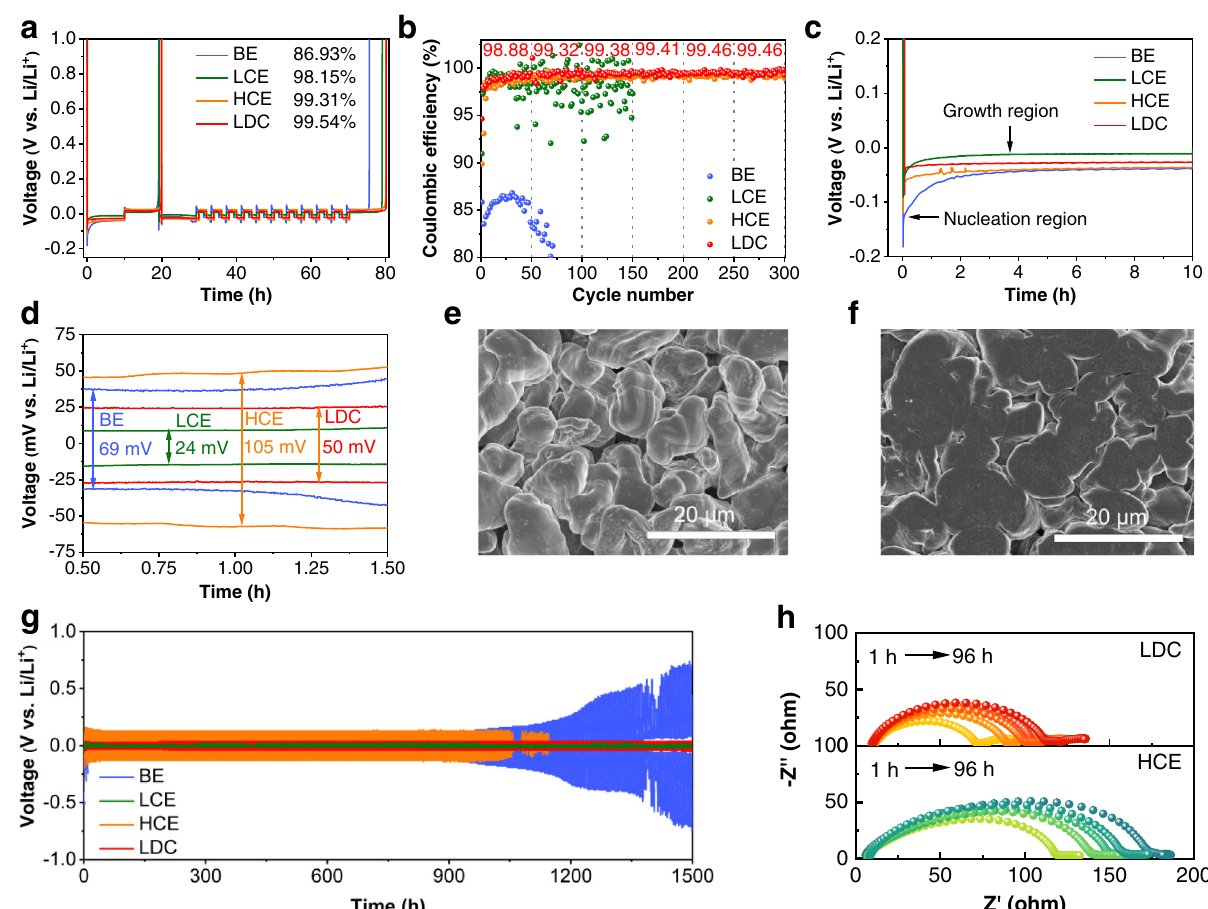
Fig. 5 | Electrochemical behavior of LMA in different electrolytes. CE of LMA in Li||Cu cells by a using Aurbach ’ s method and b repeated plating/stripping (0.5mAcm − 2 /1mAhcm − 2 ). c Voltage pro fi les of Li plating on Cu at 0.5mAcm − 2 . d OverpotentialsofLi||CucellsintheLigrowthregion.SEMimagesofdepositedLi